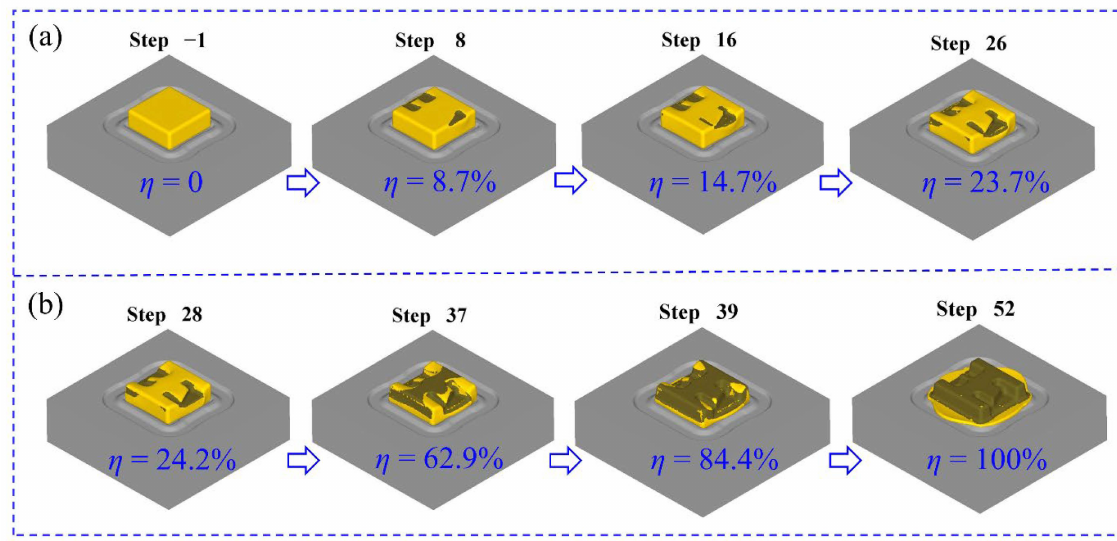
Figure 7. The main forming process of the component: ( a ) pre-forging and ( b ) final